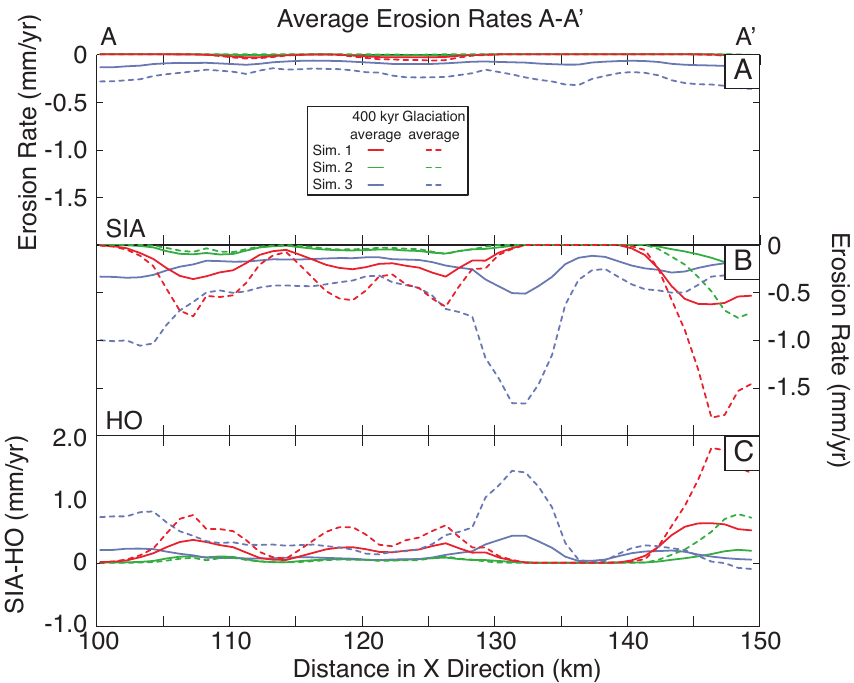
Figure 7. Erosion rates over the A–A’ orogen-parallel swath profile (Fig. 1). (a) SIA erosion rates averaged over the 100kyr glaciation (dashed line; grey-shaded area in Figs. 3 and 4) and over the full simulation (solid line). (b) HO erosion rates averaged over the 100kyr glaciation (dashed line) and over the full simulation (solid line). (c) Difference between the time-averaged erosion rates